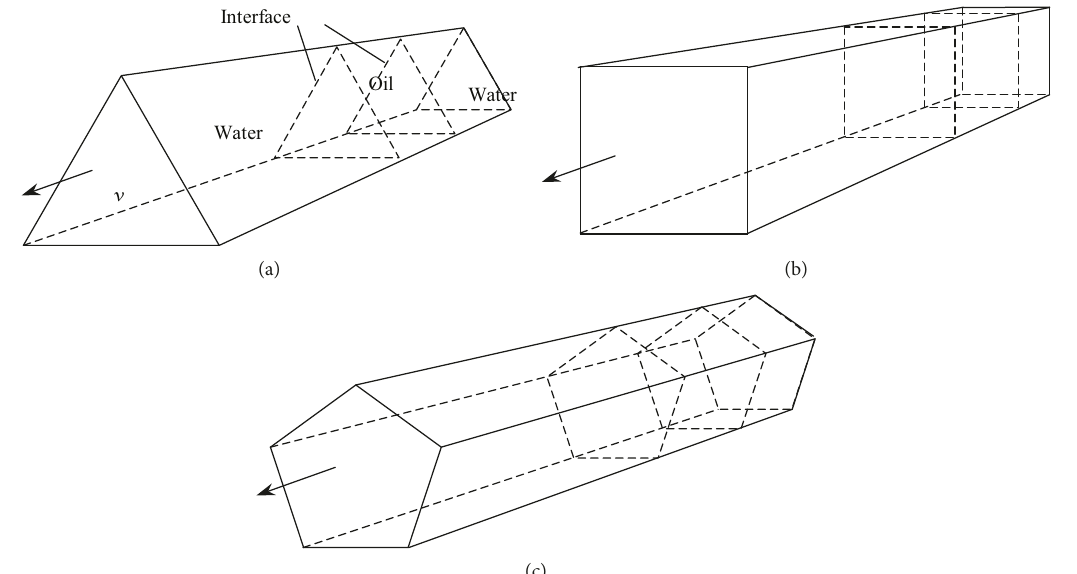
Figure 3: Initialization state diagram: (a) equilateral triangular cross section, (b) quadrilateral cross section, and (c) pentagonal cross Table 1: Fluid properties of oil and water. Fluid